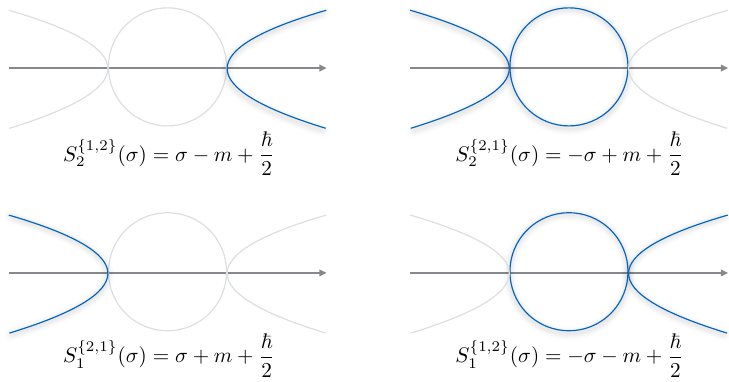
1 , X 2 , Y 1 , Y 2 to vanish